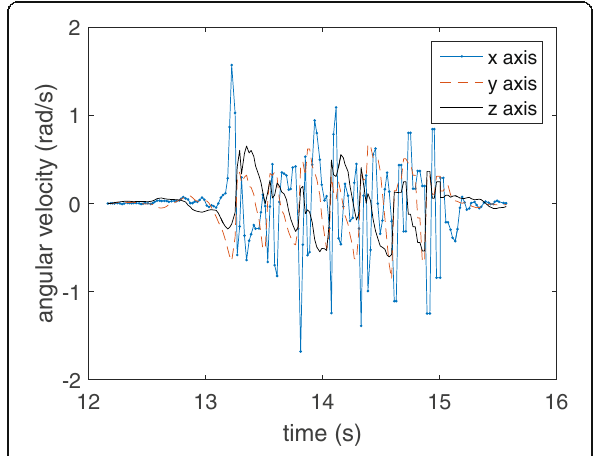
Fig. 2 The gyroscope data when a user types “ 924673 ” followed by “ Enter ”